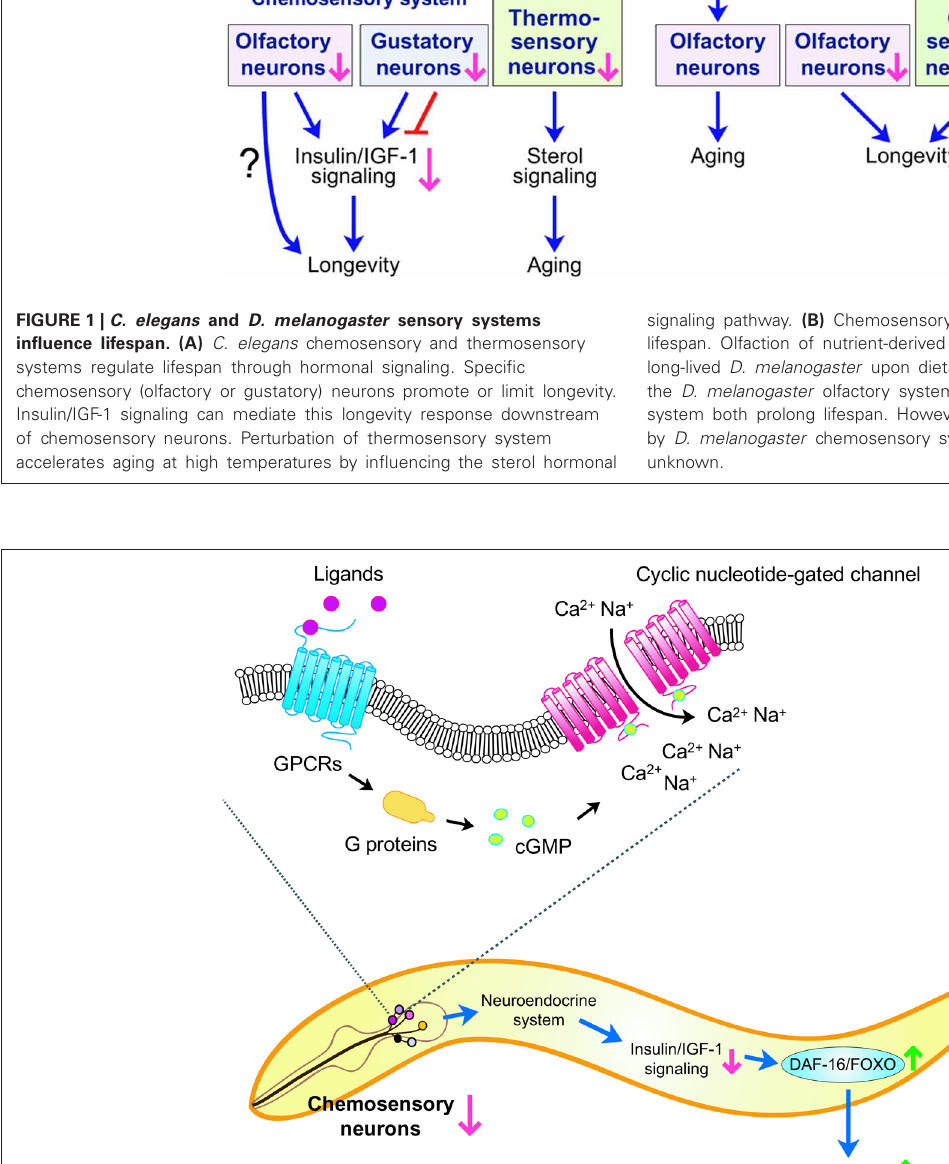
FIGURE 2 | Model of lifespan control by chemosensation and insulin/IGF-1 signaling in C. elegans . A subset of ciliated neurons in the head region (for example, in the amphid) perceive chemosensory cues and trigger signal transduction cascades. Upon binding to ligands, chemosensory G protein-coupled receptors (GPCRs) activate G proteins, which lead